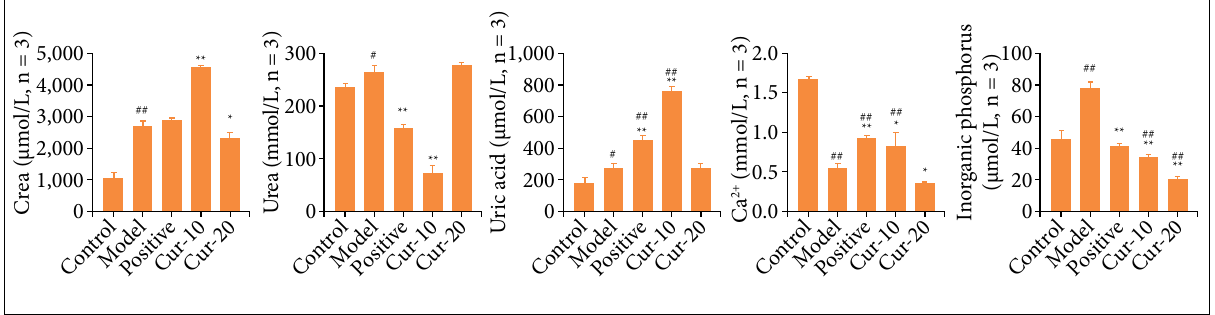
Figure 2 – Urine biochemical test results. Changes of Cr, Ur, UA, Ca 2+ , and IP in urine (n = 3). The differences between two groups were measured